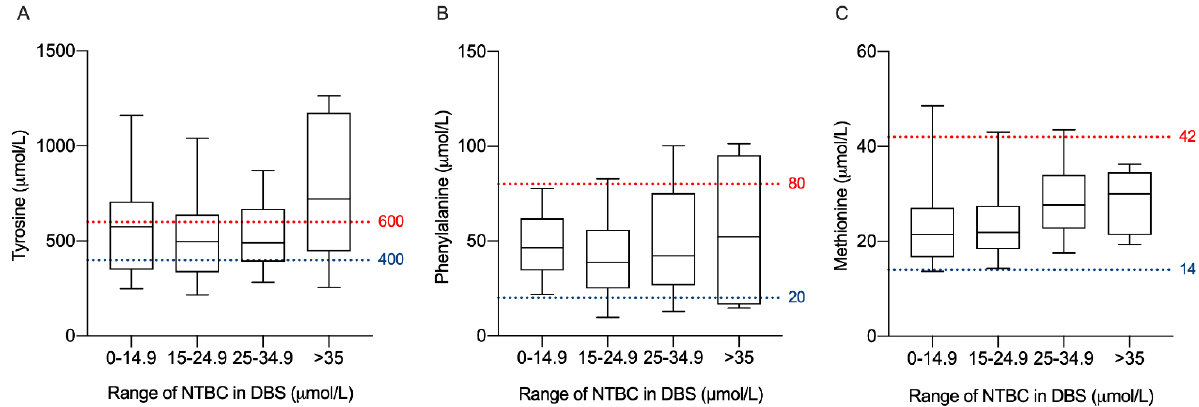
Figure 3. Amino acid variation according to NTBC concentration ranges. Boxplots of Tyr ( A ); Phe ( B ); and Met ( C ) by NTBC concentration ranges. Each boxplot represents the 25th, 50th, and 75th quartiles for each amino acid. Dotted lines represent maximum and minimum allowable concentrations under clinical guidelines: Tyr, 400–600 µ mol/L (for patients >6 years old); Phe, 20–80 µ mol/L; Met, 14–42 µ mol/L. Tyr, tyrosine; Phe, phenylalanine; Met, Methionine; DBS, dried blood spot.